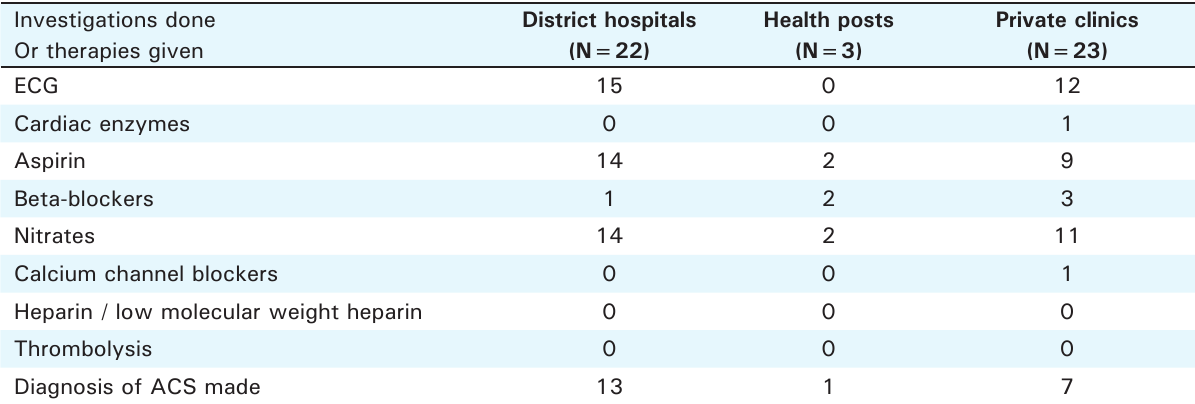
table 1. comparison of various investigations done and therapies given in different healthcare setups before referring to bPKIHs.